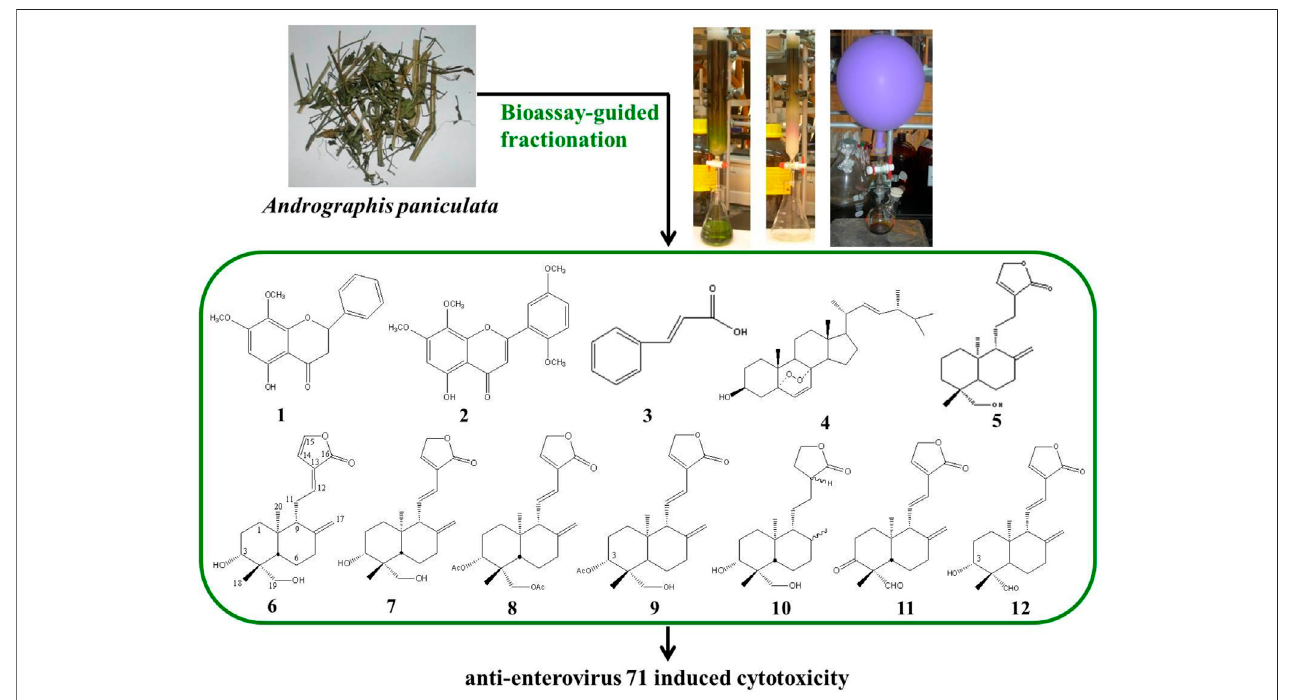
FIGURE 5 | Schematic summary of the current